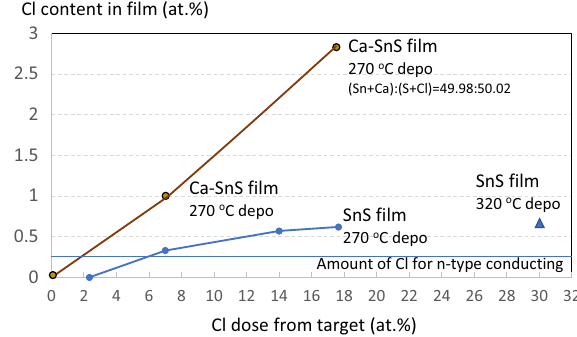
Figure 4. Cl content in as-deposited SnS film and Ca-alloyed SnS